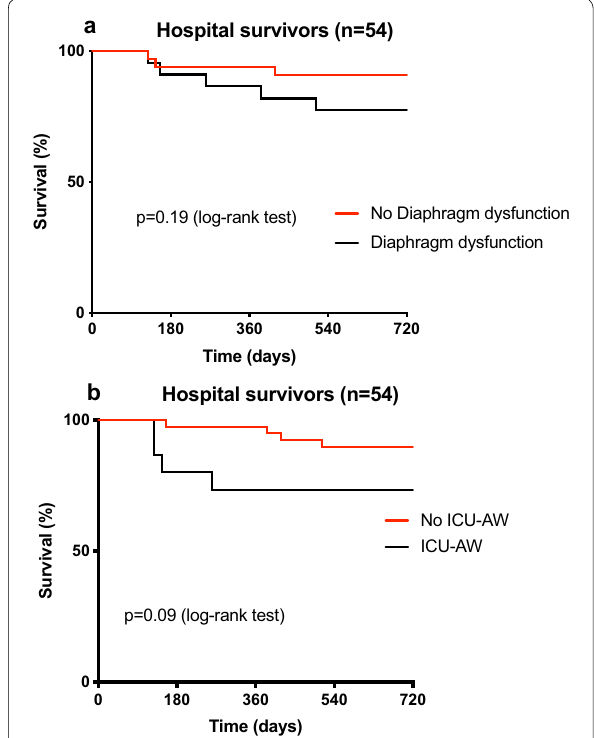
Fig. 3 Kaplan–Meier 2‑year survival curves in patients with and without diaphragm dysfunction ( a ) and in patients with and without ICU‑AW ( b ) (sensitivity analysis restricted to hospital